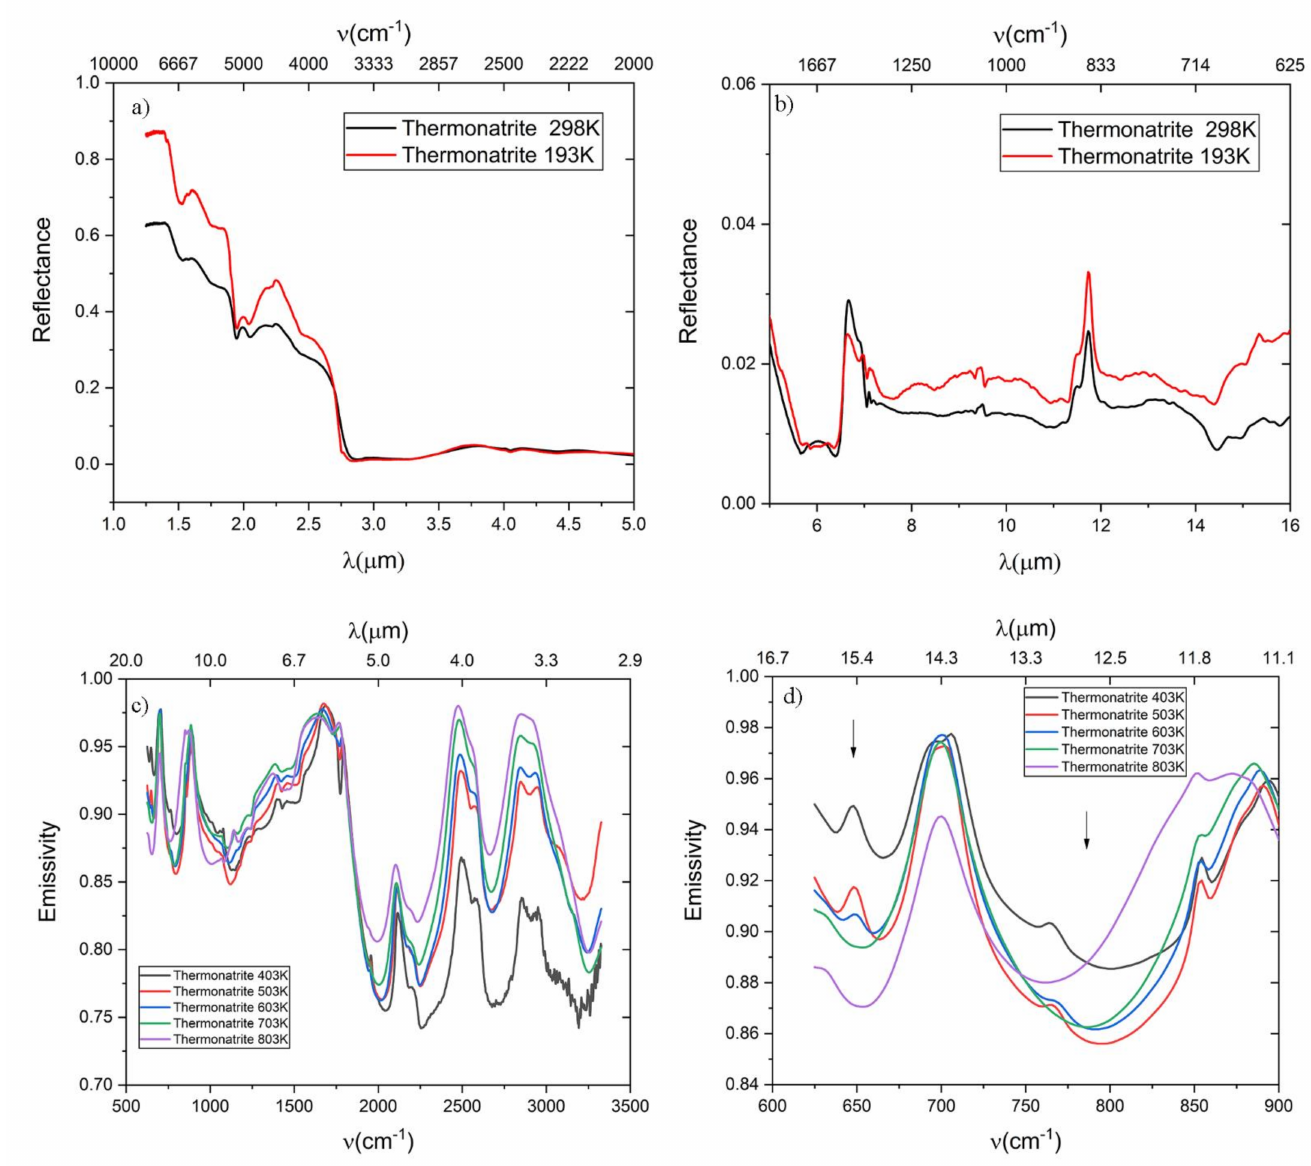
Figure 8. Reflectance spectra at room temperature and 193 K ( a , b ) and emissivity measurements from 403 to 803 K ( c ) of thermonatrite. ( d ) Focus on the absorption bands cantered at ≈ 669 and ≈ 794 cm − 1 (denoted by arrows) for the emissivity spectra of sample defined thermonatrite Na 2 CO 3 · H 2